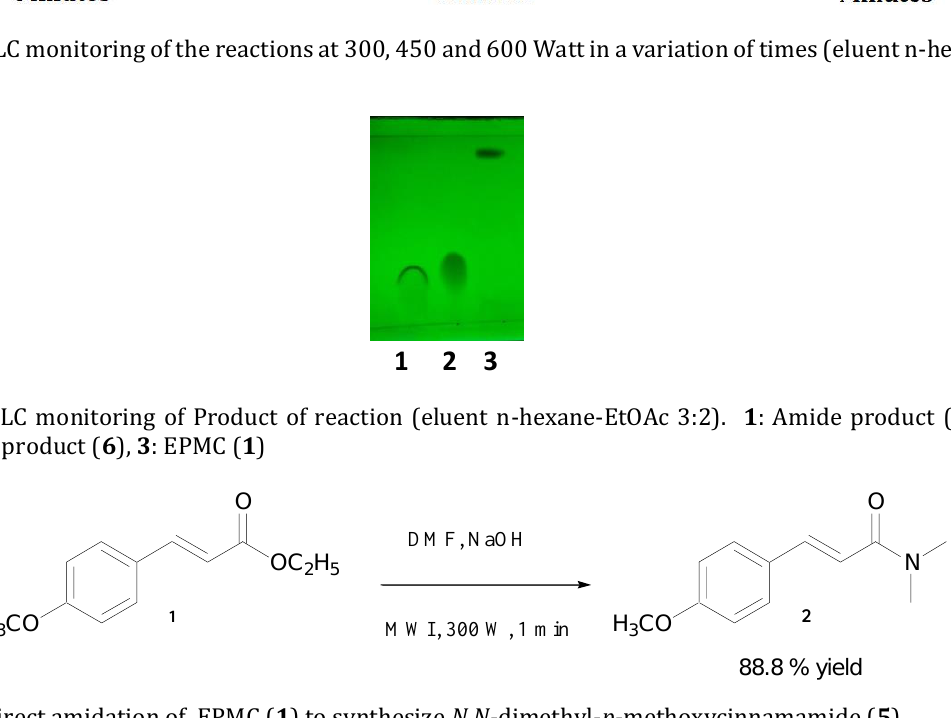
Figure 4. Direct amidation of EPMC ( 1 ) to synthesize N,N -dimethyl- p -methoxycinnamamide ( 5